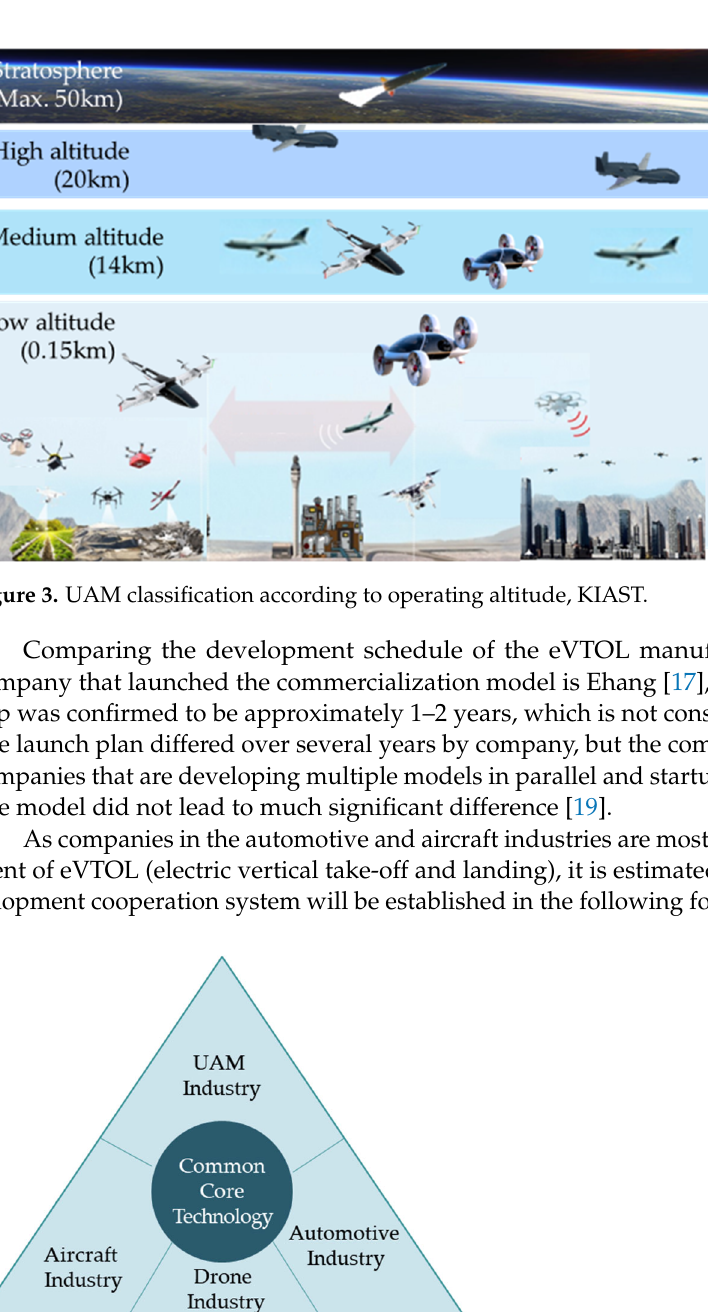
Figure 2. UAM classification by wing shape (https://transportup.com/ (accessed on 7 March 2022)).